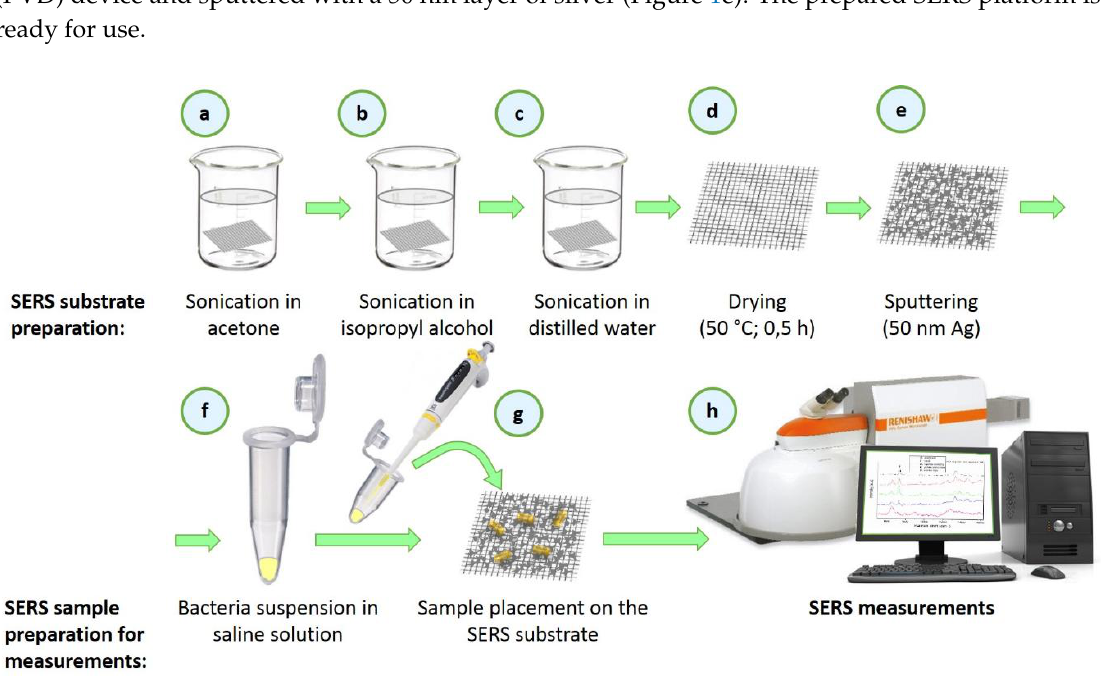
Figure 1. The scheme showing the preparation of SERS substrate, sample deposition and SERS measurement. The main steps involve cleaning ( a – c ), drying ( d ), sputtering of thin layer of silver ( e ), deposition of bacteria on SSWM platform ( f – g ), and SERS measurement ( h ).